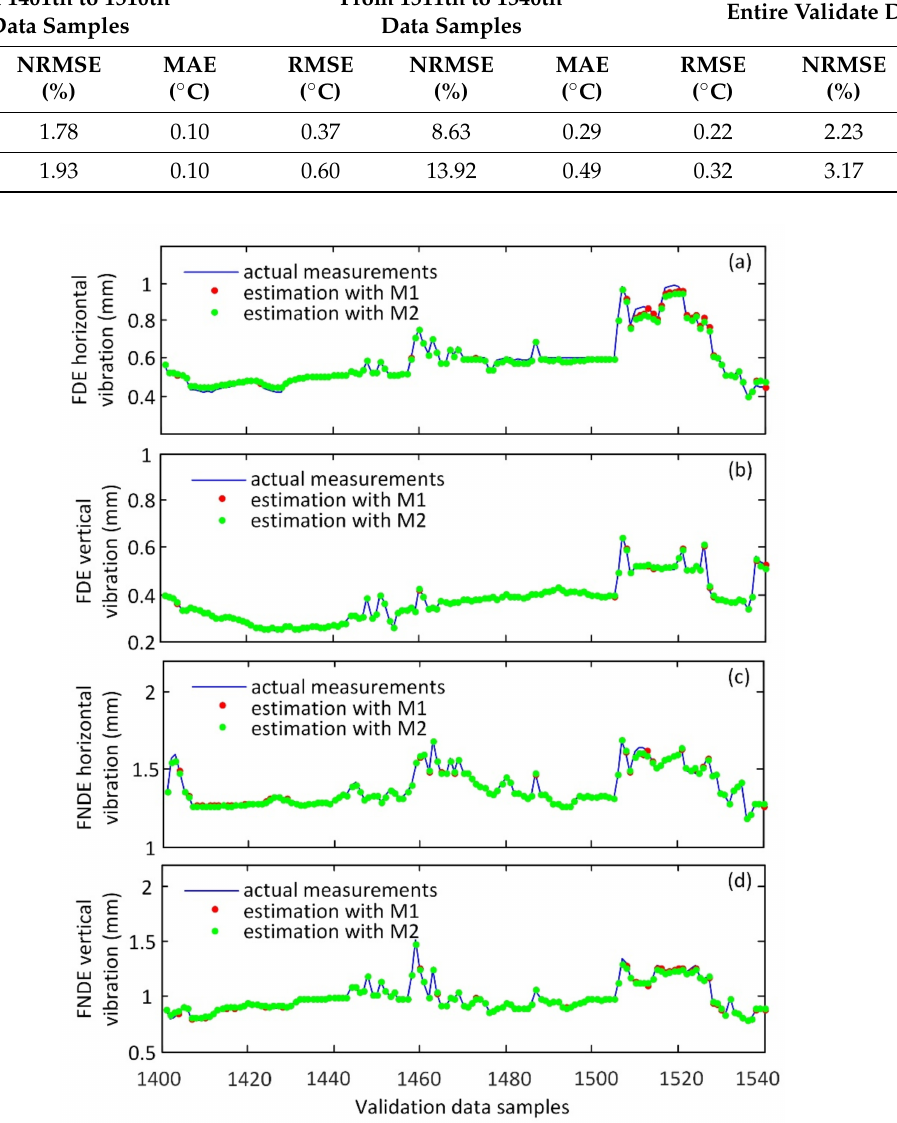
Figure 8. Estimation results of validation dataset by using models M1 and M2: ( a ) FDE horizontal vibration, ( b ) FDE vertical vibration, ( c ) FNDE horizontal vibration, and ( d ) FNDE vertical